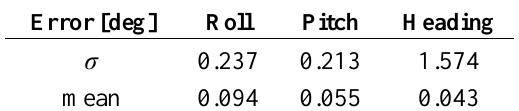
Table 3. Standard deviation and mean of the TCAPLL attitude